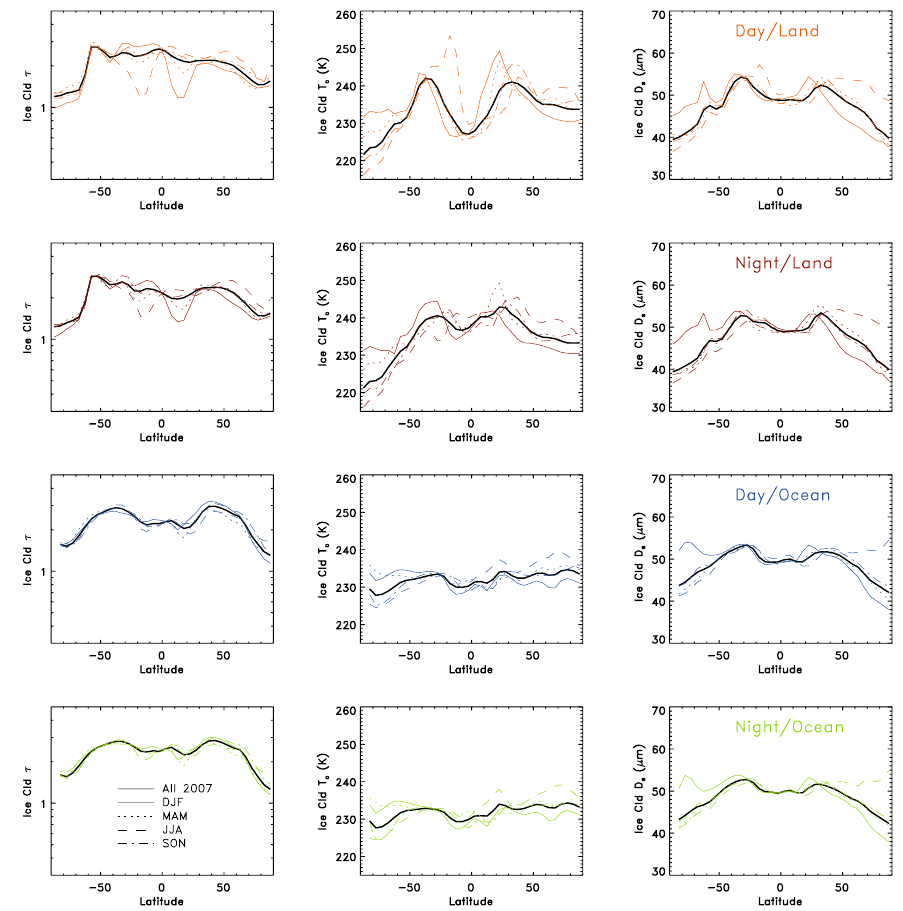
Fig. 13. Zonal averages of τ (left column), T C , ICE (center column), and D e (right column) for all of 2007, and also for DJF, MAM, JJA, and SON. The global results are in black (repeated from Fig. 12), while the seasonal day vs. night and land vs. ocean distributions are highlighted in